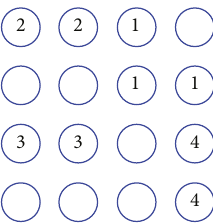
Figure 10: The correlations of predictive variables TI represents a bracket number where bolt loosening happens.